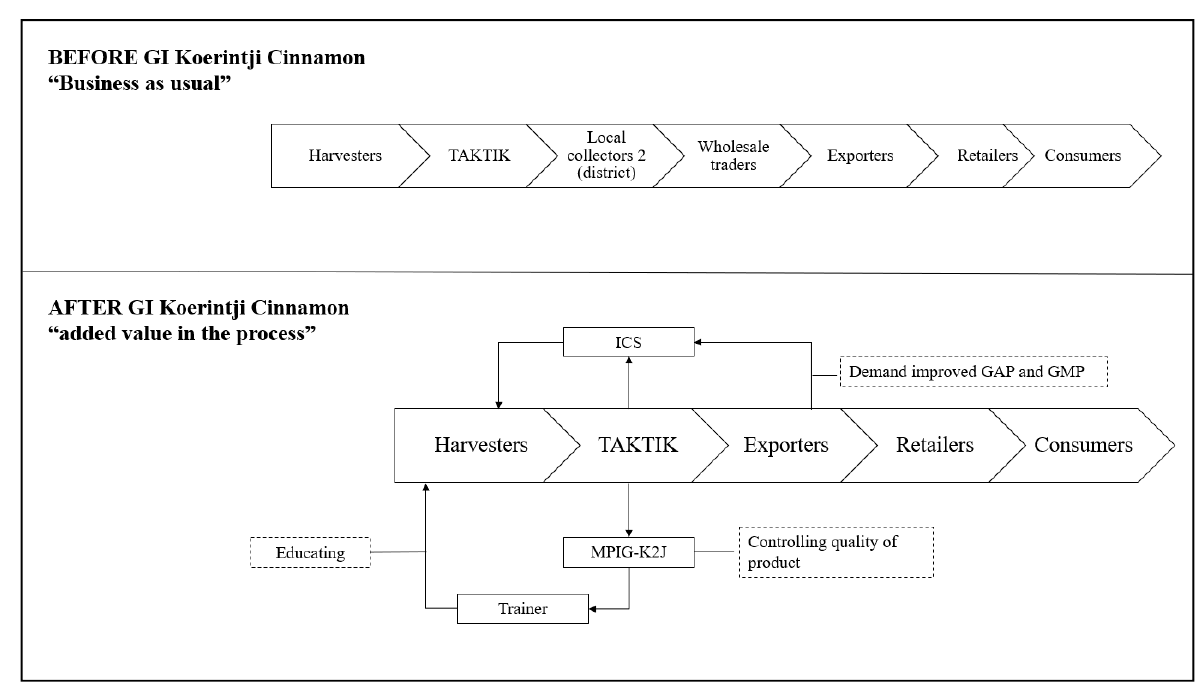
Figure 9. Value chain before and after GI Koerintji cinnamon.